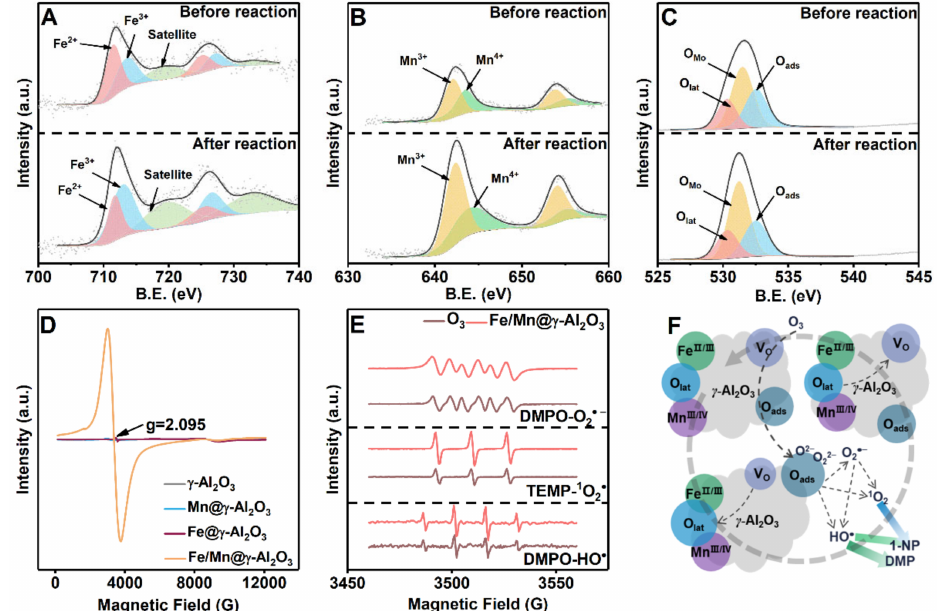
Figure 3. XPS spectra of Fe 2p ( A ), Mn 2s ( B ), and O 1s ( C ) for Fe/Mn@ γ − Al 2 O 3 before/after catalytic ozonation; oxygen vacancy of γ − Al 2 O 3 and Fe/Mn@ γ − Al 2 O 3 ( D ); the EPR spectra of HO ◦ and O 2 ◦− using DMPO in water and methanol respectively, and the EPR spectra of 1 O 2 using TEMP from single ozonation and catalytic ozonation processes ( E ); the proposed catalytic ozonation mechanism of Fe/Mn@ γ − Al 2 O 3 ( F